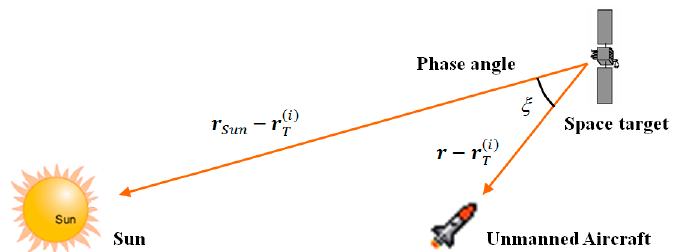
Figure 3. Relative positions of the Sun, space target and unmanned aircraft.